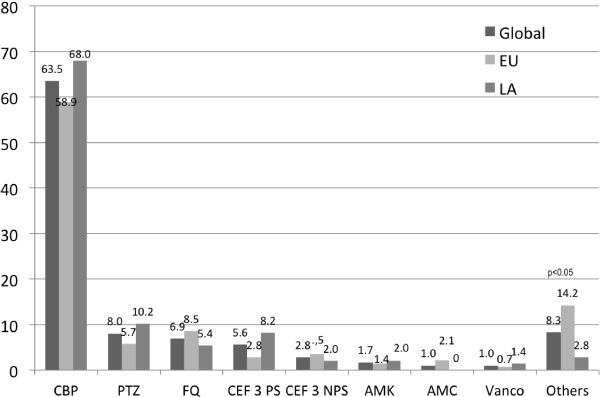
Empiric antibiotic therapy for late ventilator-associated tracheobronchitis. AMC, amoxicillin/clavulanate; AMK, Amikacin; CBP, carbapenem; CEF3 NPS, third-generation non-Pseudomonal cephalosporins; CEF3 PS, third-generation Pseudomonal cephalosporins; EU, European Union group; FQ, fluoroquinolones; LA, Latin American group; PTZ, Piperacillin/Tazobactam; Vanco: vancomycin.